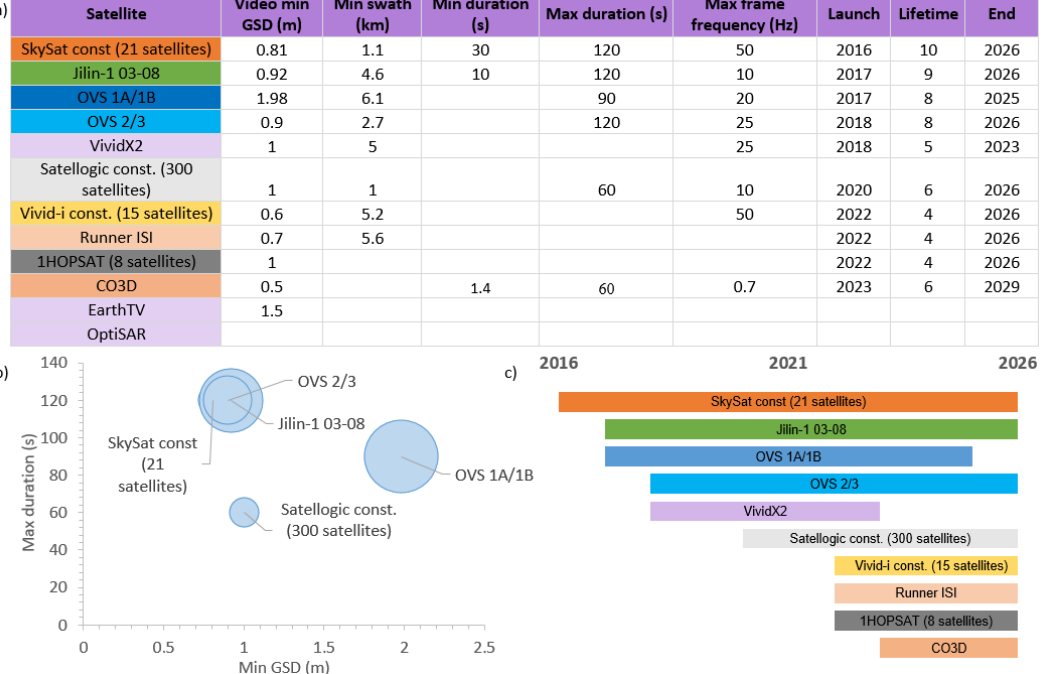
Figure 5. A review of current and future satellite video missions. Table and graphics showing the main optical video mission characteristics and lifetime, with some video duration versus ground sampling distance (GSD). ( b , c ) Present missions only from all the missions in ( a ). This table may contain incomplete and outdated information. Updated documentation can be found on satellite mission web